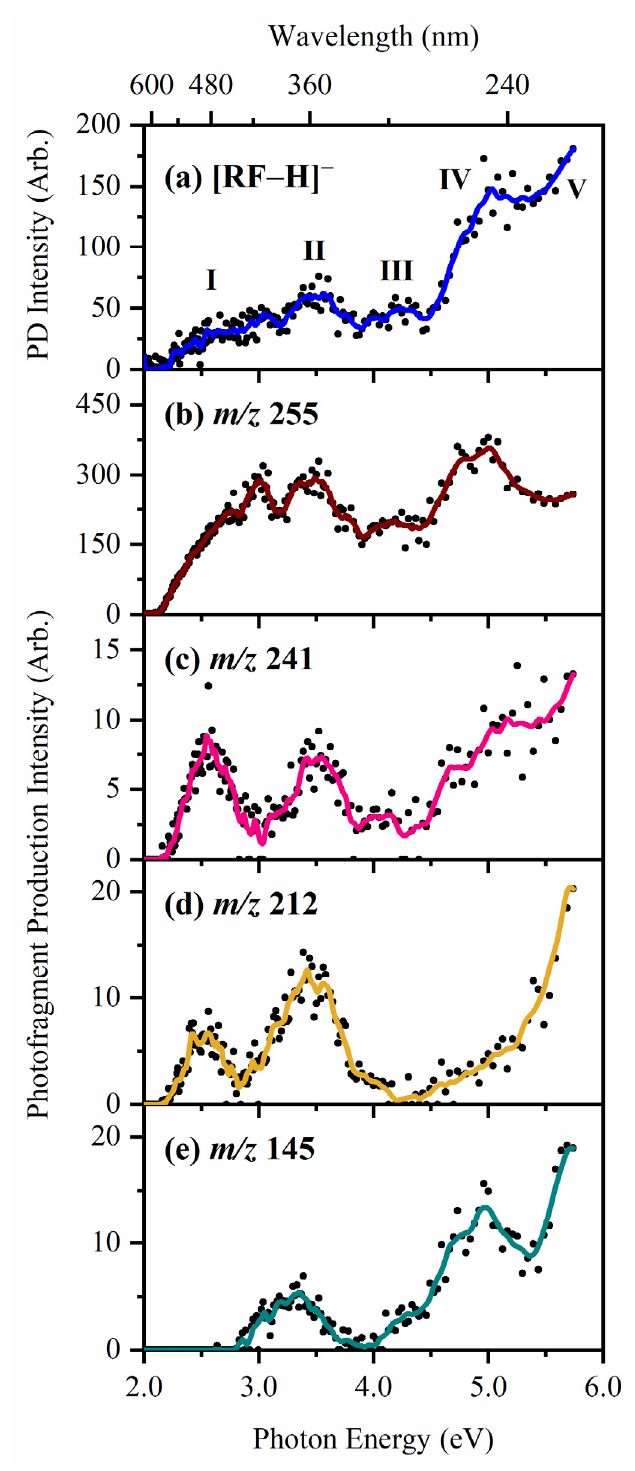
Figure 4. ( a ) Gas-phase photodepletion (absorption) spectrum of [RF − H] − ( m / z 375). ( b–e ) Photofragment production spectra of the four major [RF − H] − photofragment ions at m / z 255, 241, 212, and 145, respectively. The solid line is a five-point adjacent average of the data points.